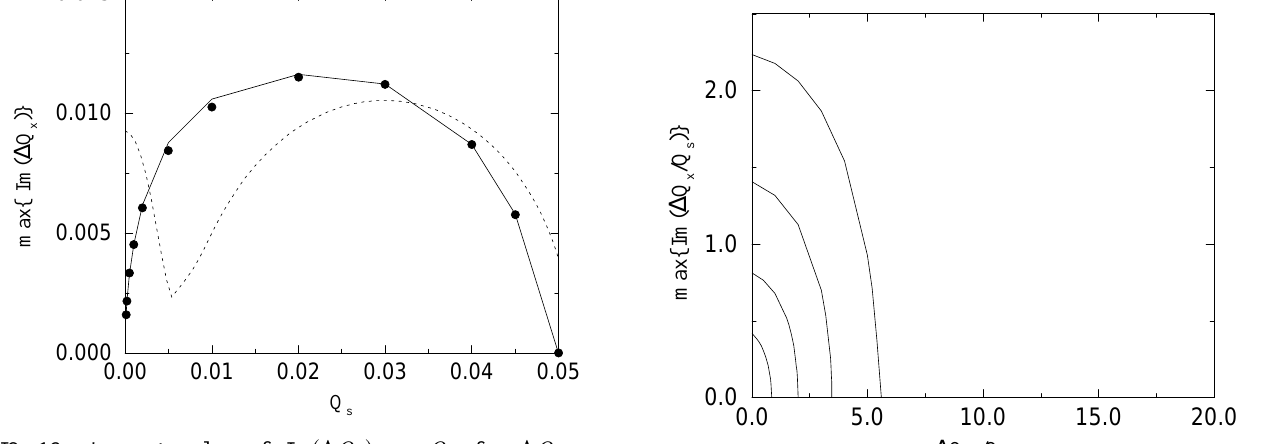
FIG. 12. Largest value of Im (cid:115) D (cid:81) (cid:120) (cid:100) vs (cid:81) (cid:115) for D (cid:81) (cid:115)(cid:99) (cid:173) a (cid:173) j (cid:173) (cid:48) with k (cid:87) (cid:48) t (cid:98) (cid:173) (cid:48)(cid:46)(cid:48)(cid:53)(cid:53) : simulations in a harmonic potential with m (cid:173) 2 (cid:49) (cid:121) (cid:50) circles; analytic square well model, solid line; basis expansion for the boxcar distribution with (cid:109) max (cid:173) (cid:53) , short dashed line.